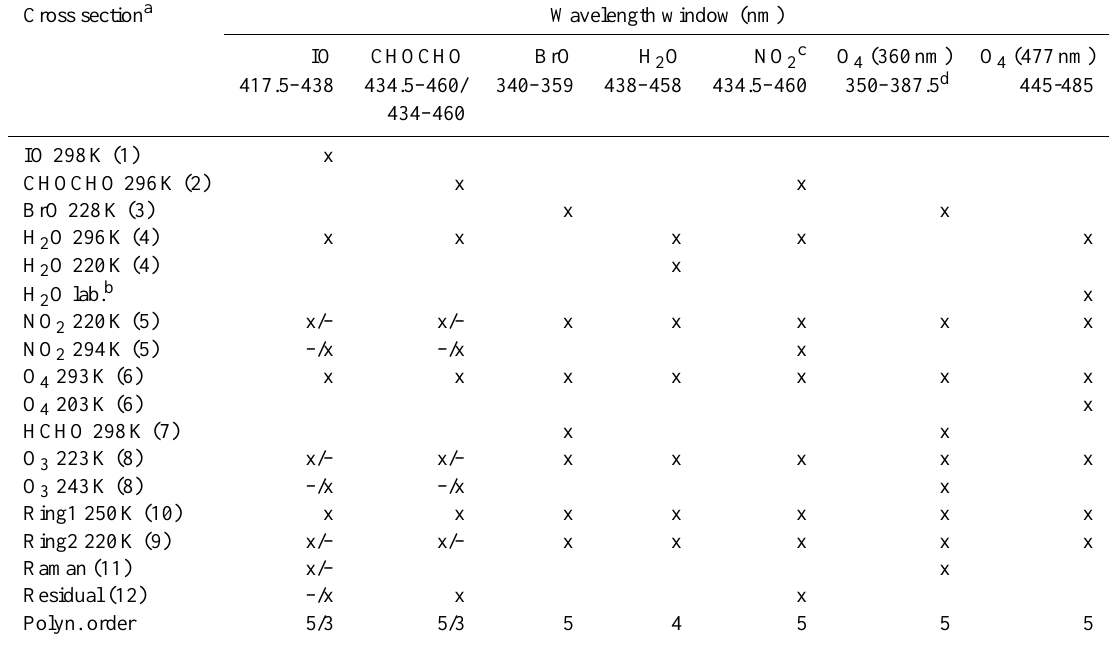
Table 1. AMAX/SMAX-DOAS analysis settings. Cross section a Wavelength window (nm) IO CHOCHO BrO H 2